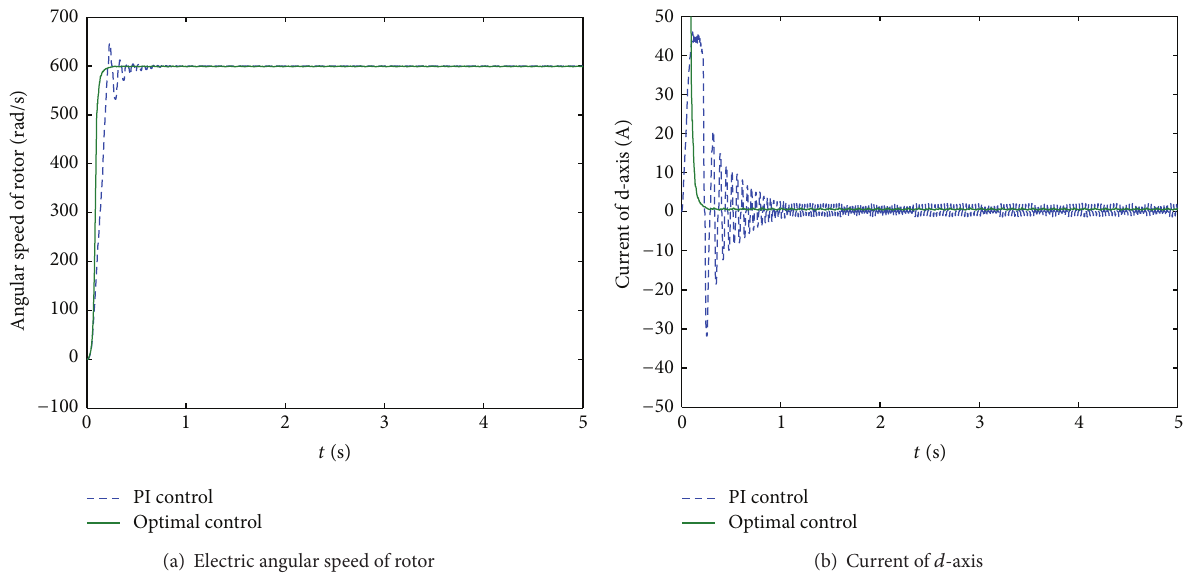
Figure 6: The simulation results of case III (from the initial state of storing half of full of energy to the final state of storing full of energy).